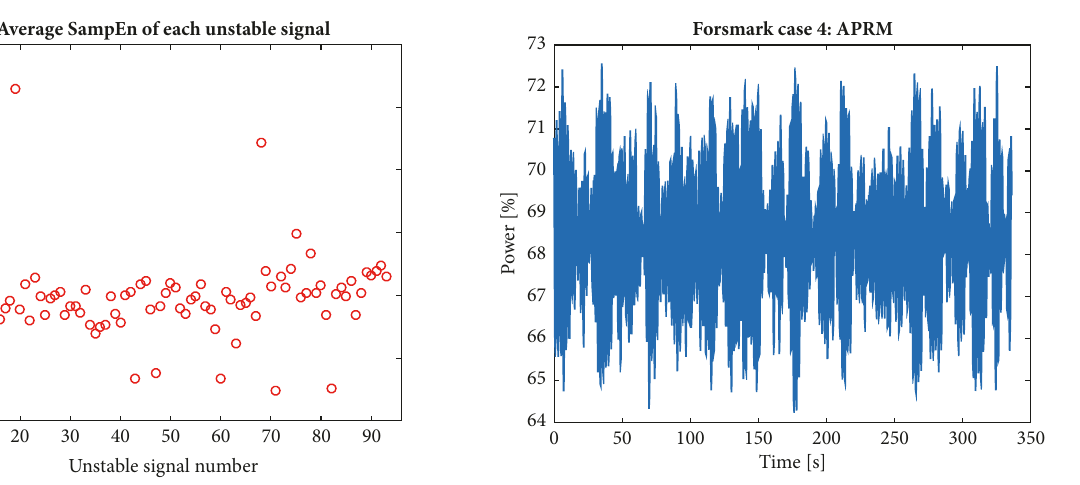
Figure 15: Computed mean(SampEn) of the studied 96 unstable signals.